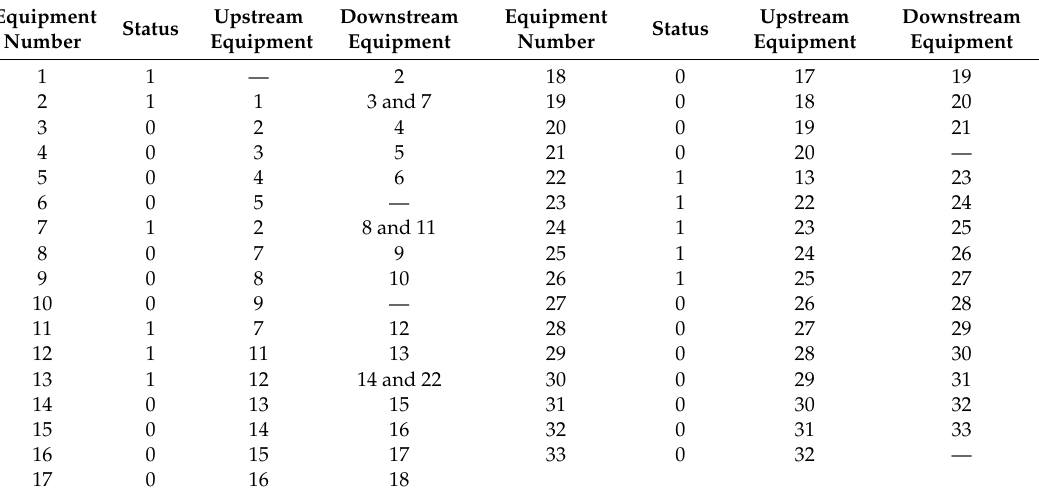
Figure 5. Single fault in the IEEE-33 node distribution network. Table 2. The line list of Figure 5.